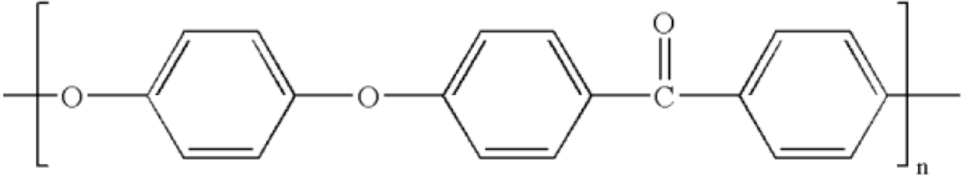
Figure 1. Chemical structure of poly (ether ether ketone) (PEEK) [60].